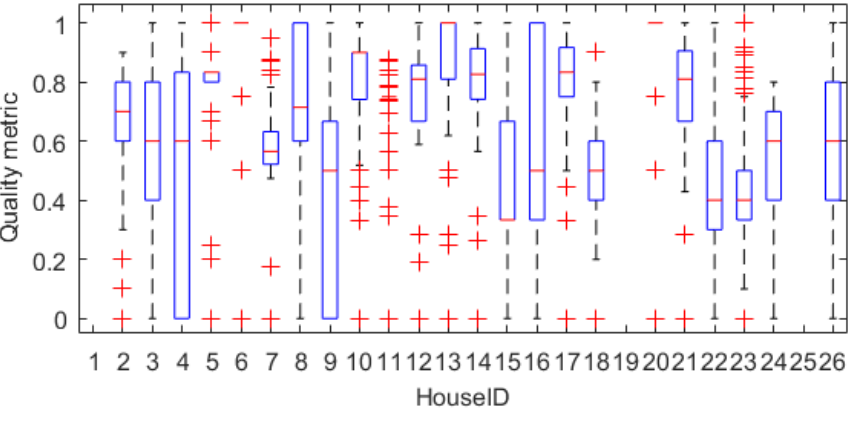
Figure 6. Data quality of 25 houses in the SmartHG